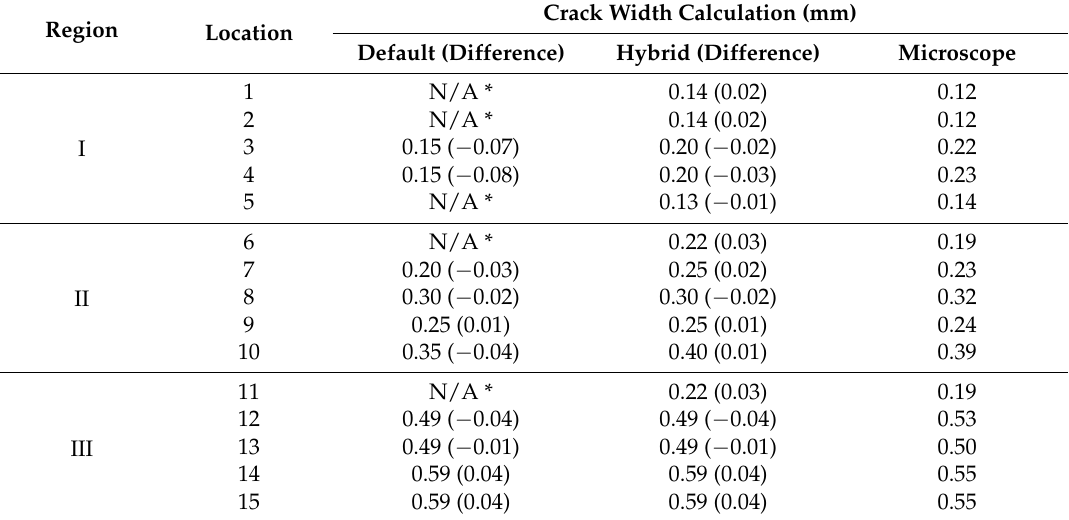
Table 4. Comparison of obtained crack widths.